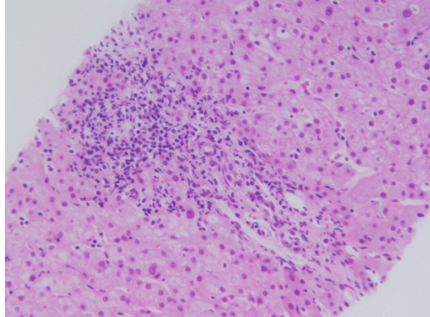
Figure 2: Liver biopsy showing portal inflammation in Subject 3 (hematoxylin and eosin stain, magnification ×